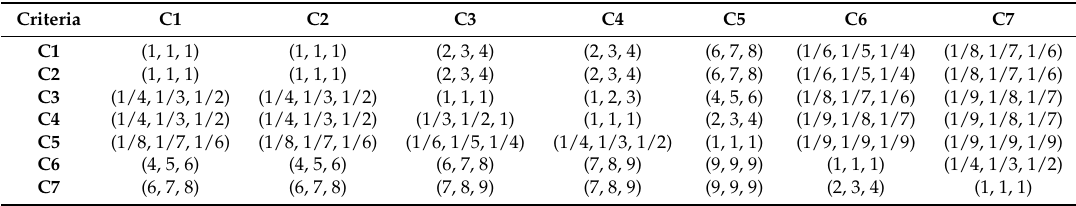
Table 3. Fuzzy Comparisons for each criteria (Expert 1).